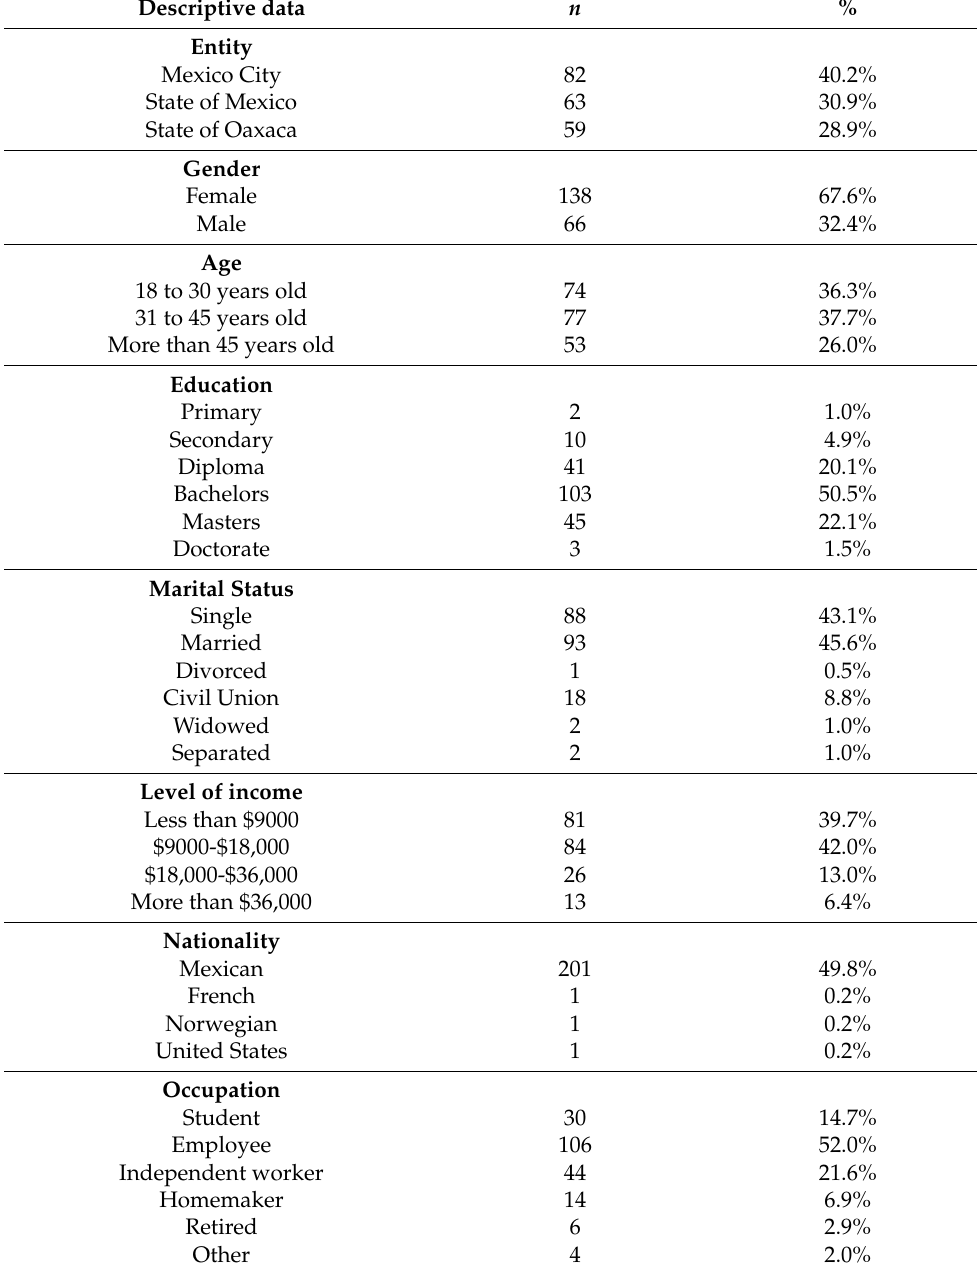
Table 3. Descriptive sample